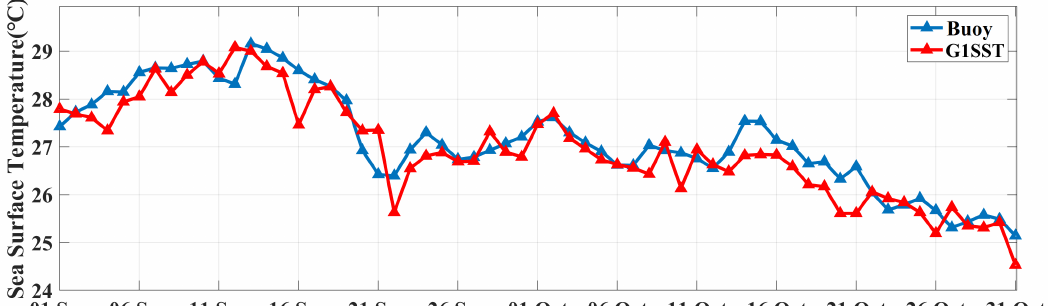
Figure 8. Comparison of the sea surface temperature between the observation (blue) and G1SST (red) from 1 September to 31